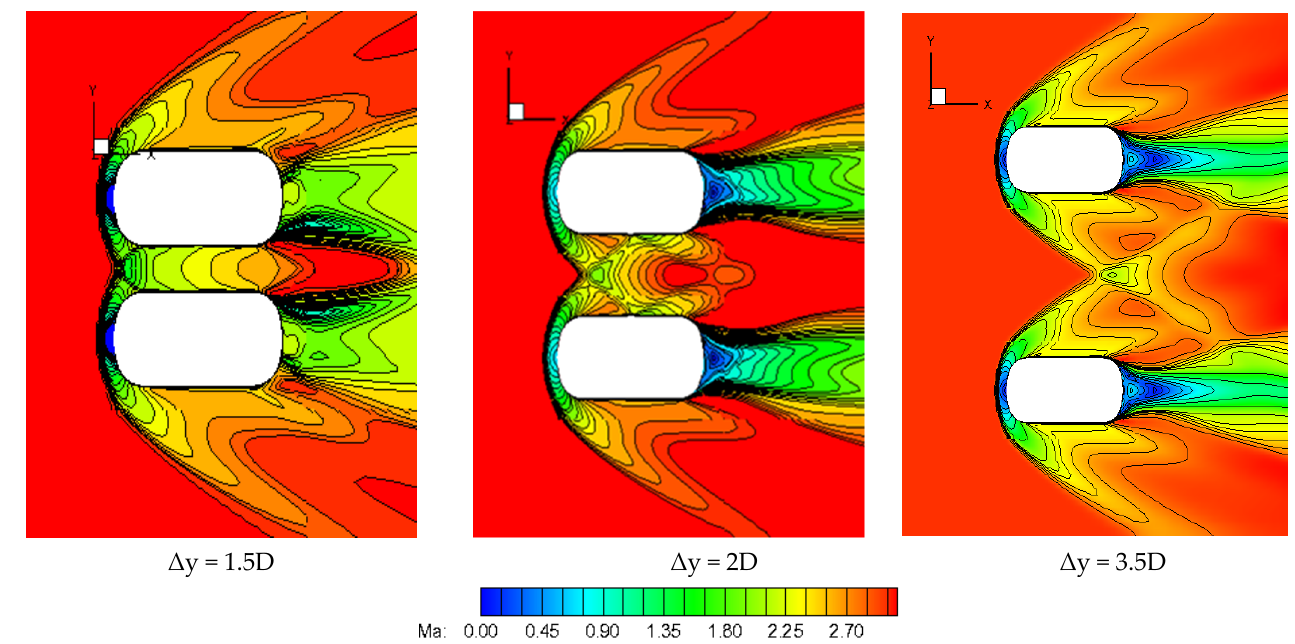
Figure 11. Mach number contours of side-by-side propelling bottles with different Δ y. Table 4. Axial and normal force coefficients of side-by-side propulsion bottles when Ma = 3 and the altitude is 40 km.